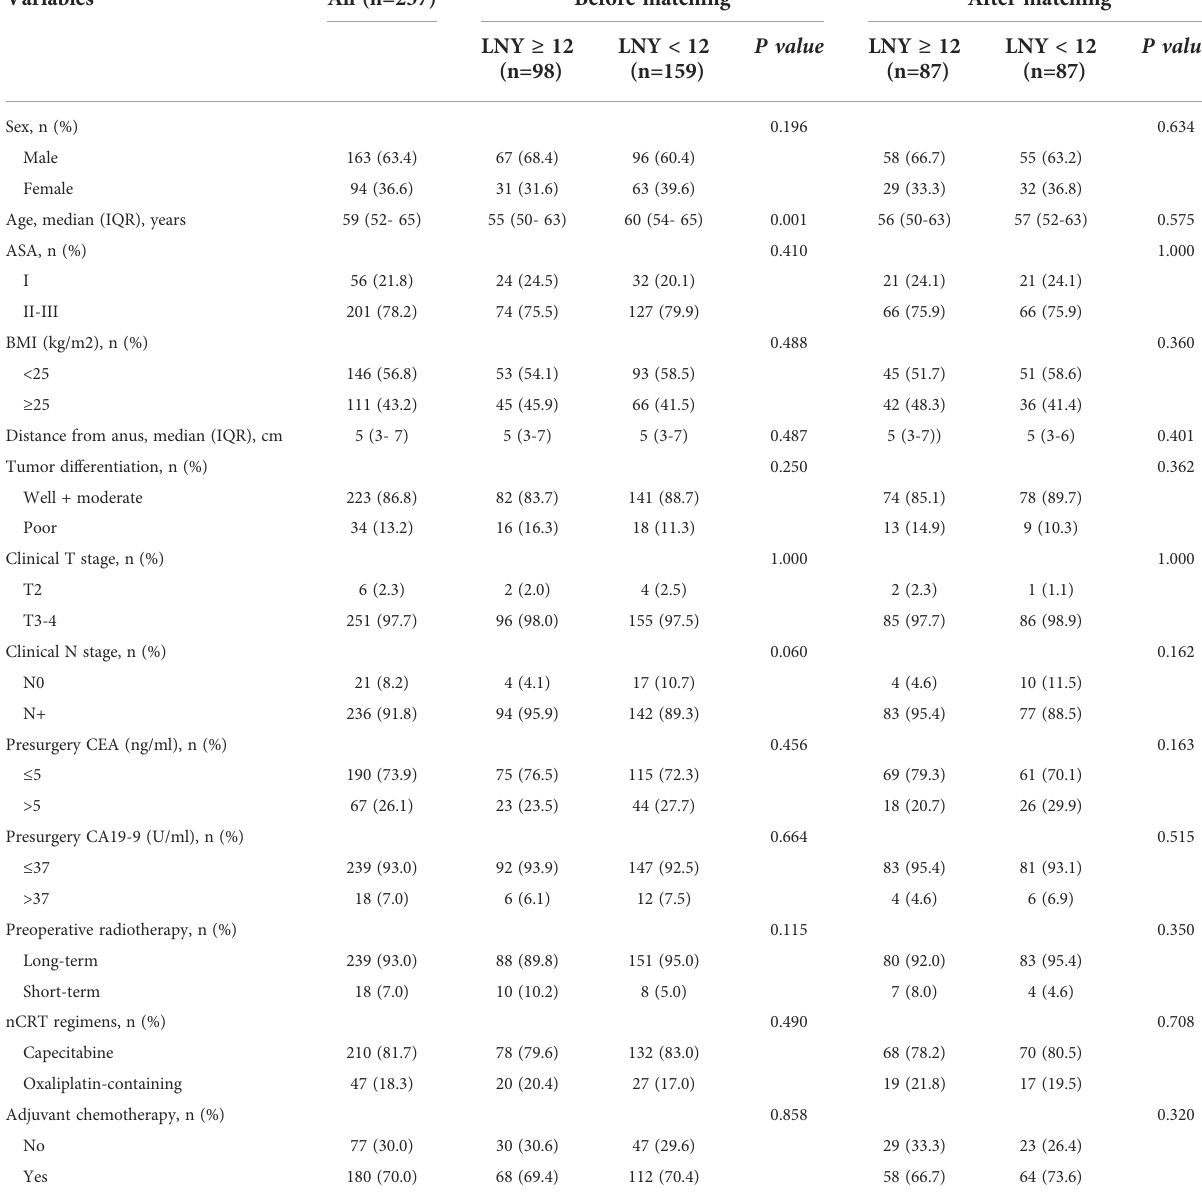
TABLE 1 Comparison of demographic characteristics between LNY ≥ 12 group and < 12 group. Variables Before